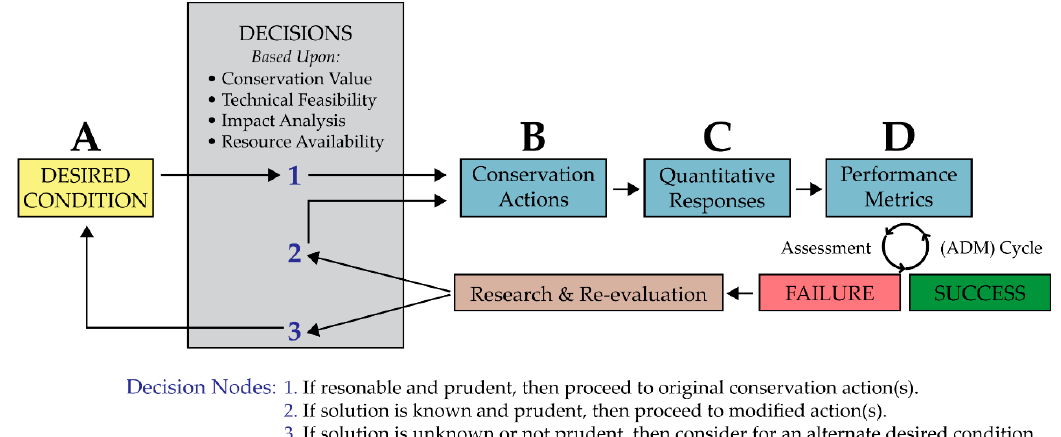
Figure 5. Adaptive management (ADM) strategy conceptual model for Yellowstone Lake ecosystem restoration. Desired condition ( A ), conservation actions ( B ), quantitative responses ( C ), and performance metrics ( D ) are defined in the text and listed in Table 1 [90].